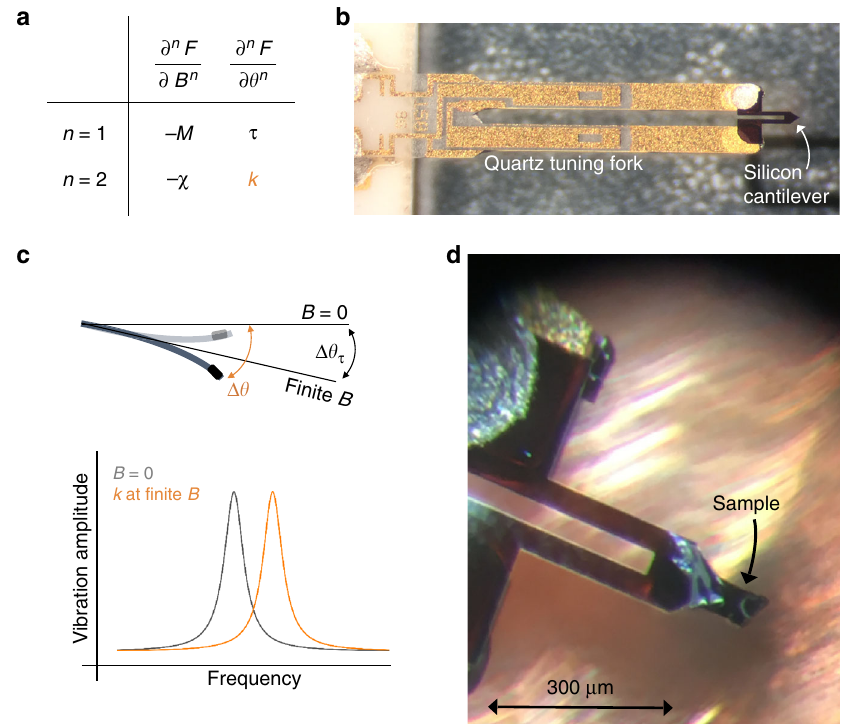
Fig. 1 Schematic overview of resonant torsion magnetometry. a First and second derivatives of the free energy with respect to the magnetic fi eld B and the fi eld orientation θ . b The quartz tuning fork of the Akiyama A-probe (http://www.akiyamaprobe.com) is electrically excited at the lowest-resonance mode of the silicon cantilever, producing a large out-of-plane motion at the tip of the cantilever. c Schematic representing the principle of measuring the magnetotropic coef fi cient k . In a magnetic fi eld, the magnetic torque brings the lever to a new equilibrium position. The magnetic energy of the samples changes the effective stiffness of the lever, leading to a shift in the resonant frequency. d The silicon cantilever glued to each leg of the quartz tuning fork with a single crystal of RuCl 3 mounted at the tip with Bayer silicone